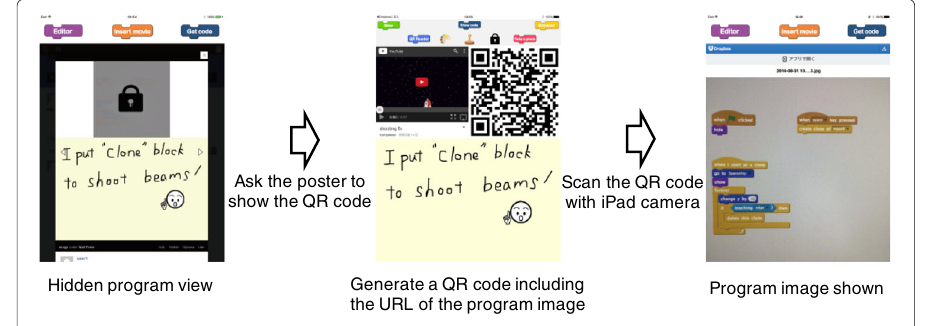
Fig. 7 Non-display function of posted